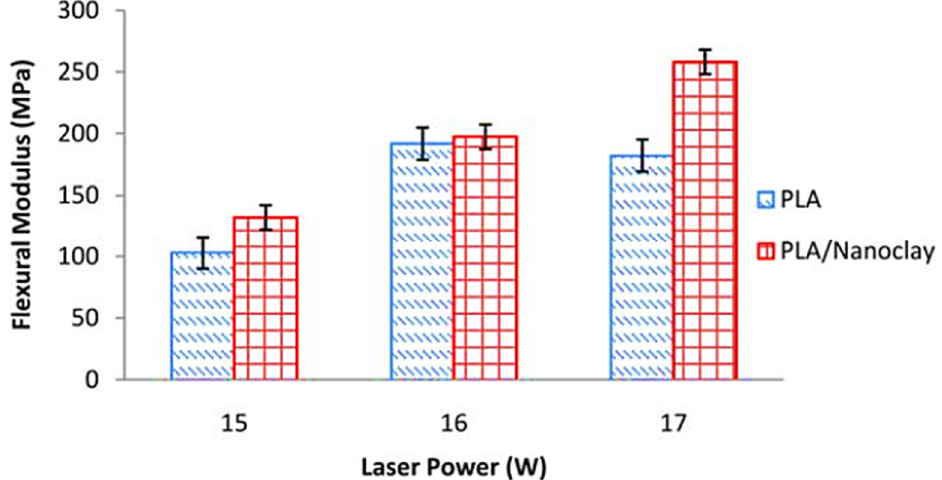
Figure 6. Variation in flexural modulus vs, laser power for poly(lactic acid) and poly(lactic acid)/montmorillonite nanoclay nanocomposite (powder bed temperature 60 °C) [138]. Reproduced with permission from Wiley.